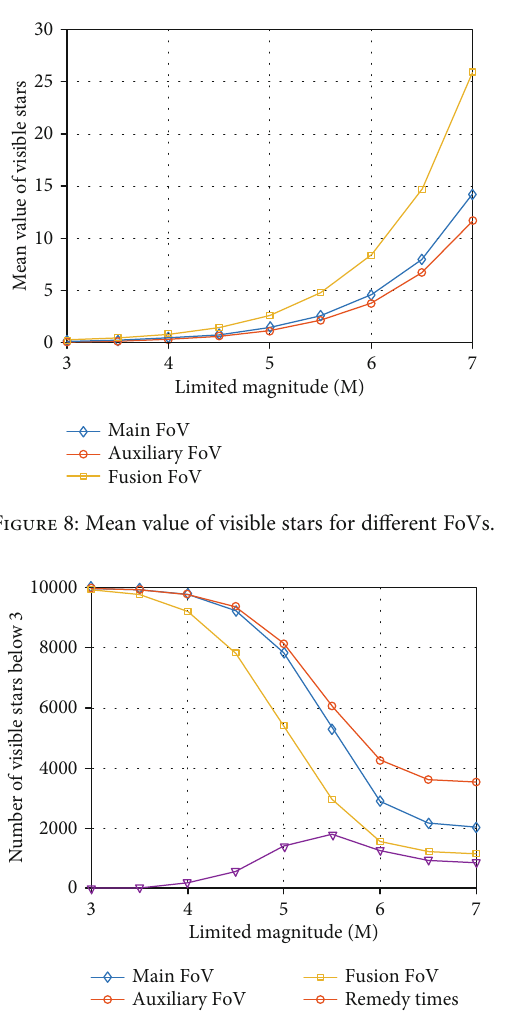
Figure 9: Numbers of instances of a number of visible stars below 3.